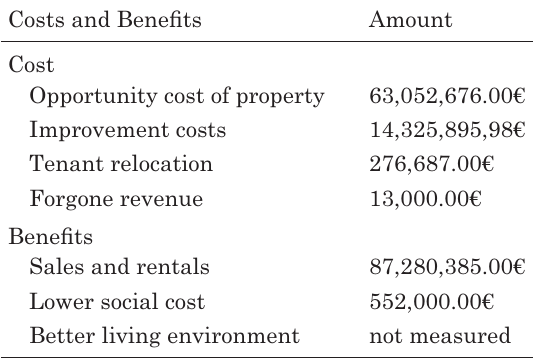
Table 2. Cost and benefi